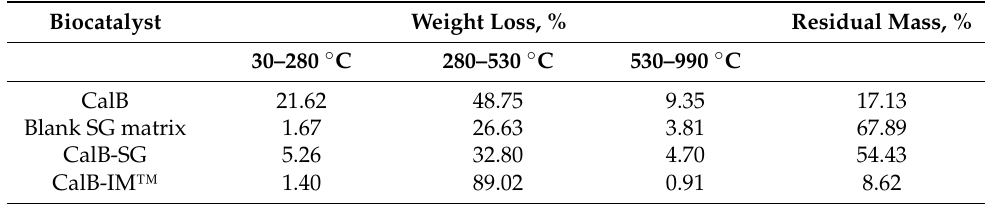
Figure 9. Thermograms showing the weight loss (TG, continuous line) and their derivative (DTG, dotted lines) for: blank sol-gel matrix (SG, green) ( a ); sol-gel immobilized Candida antarctica B lipase (CalB-SG, red) ( b ); unbound Candida antarctica B lipase (CalB, blue) ( c ), and commercial Candida antarctica B lipase preparation (CalB-IM TM , black) ( d ). Table 4. Thermal behavior of the studied biocatalysts.